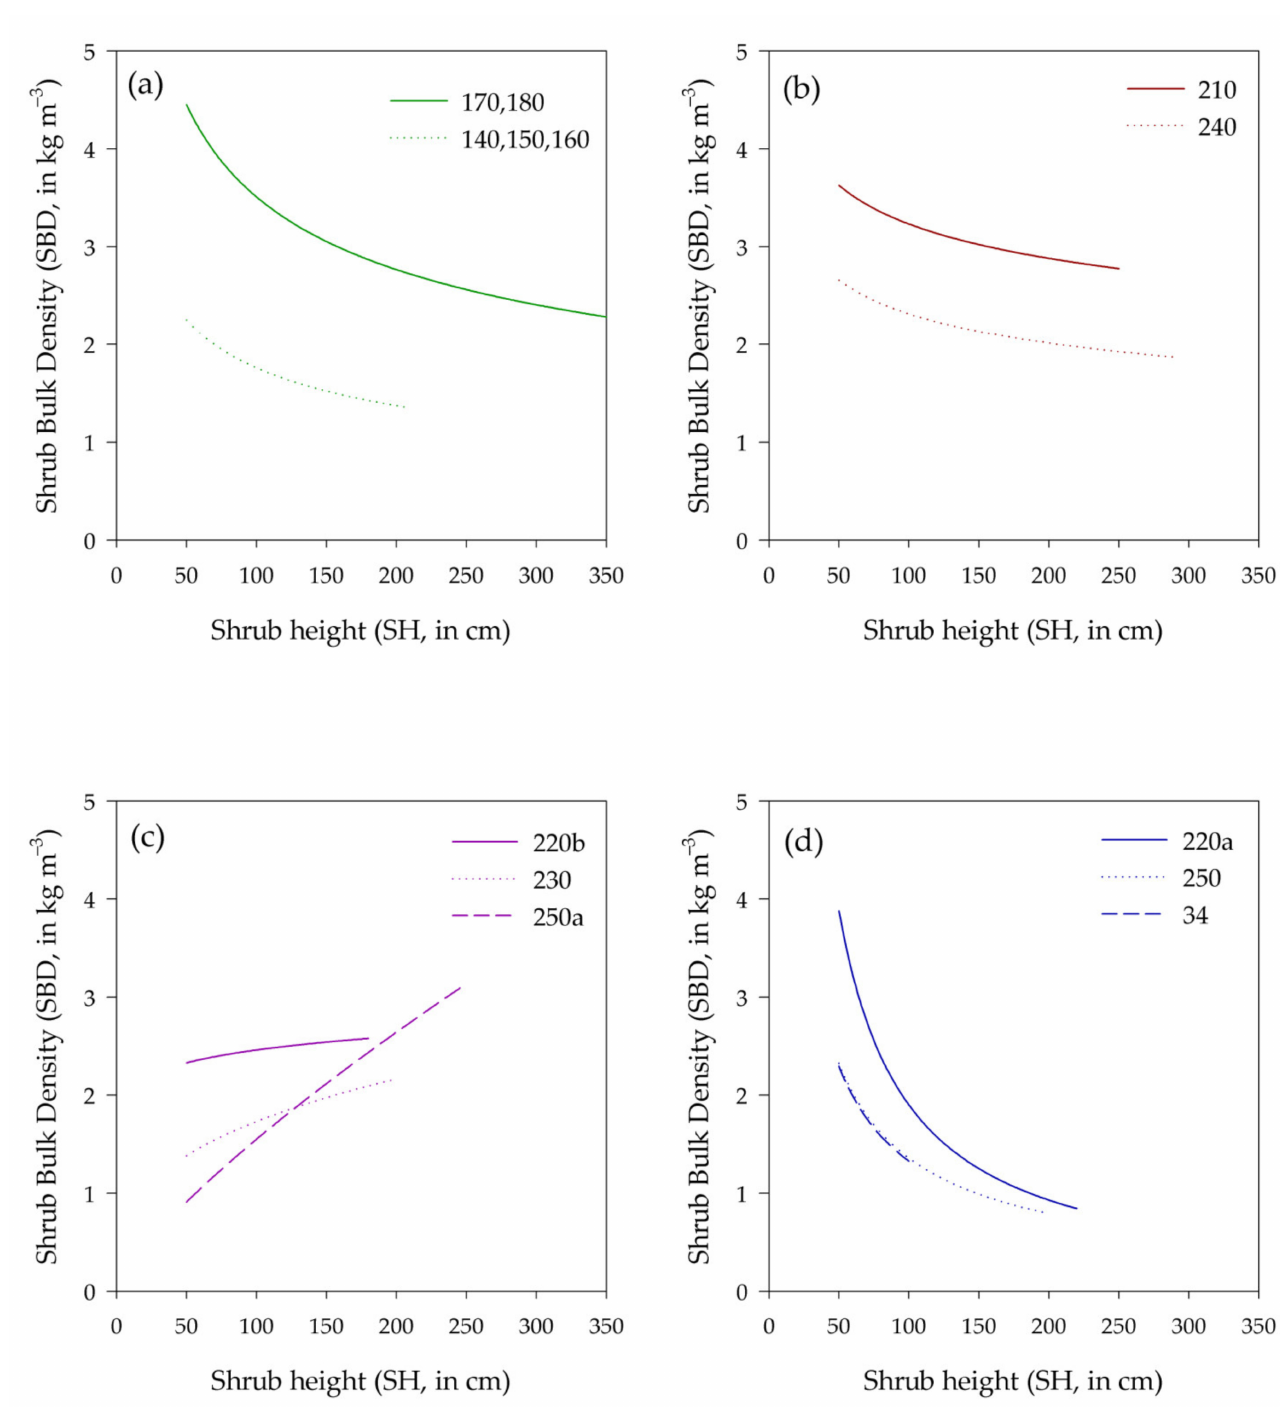
Figure 7. The variation of Shrub Bulk Density (SBD) for the 10 shrub types depending on shrub height (SH) ( a – d ). The numbers on the legend correspond to the codes of each shrub type (140, 150, 160 = Machias, terebinthus, garrigues; 170, 180 = Quercus coccifera and Pistacia lentiscus ; 210 = Heathers, Ericaceae shrubs and related groups; 220a = Small size Cistaceae shrubs; 220b = Big size Cistaceae shrubs; 230 = Mixture of broom leguminous shrubs; 240 = Ulex spp. shrubs and related groups; 250a = Rosmarinus officinalis ; 250 = Lavandula spp., Rosmarinus officinalis , Thymus spp. shrubland and Phlomis purpurea ; 34 = Ampelodesmos spp. and other